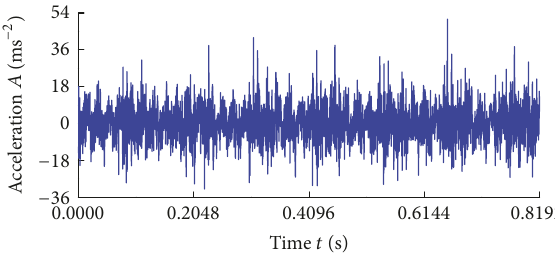
Figure 17: Real vibration signal obtained from the axle